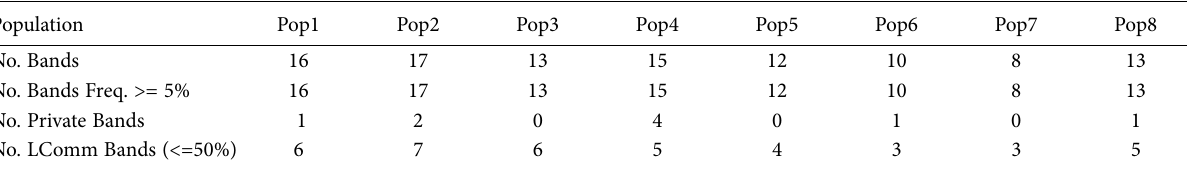
Table 1. Details of ISSR bands in Z. Jujube